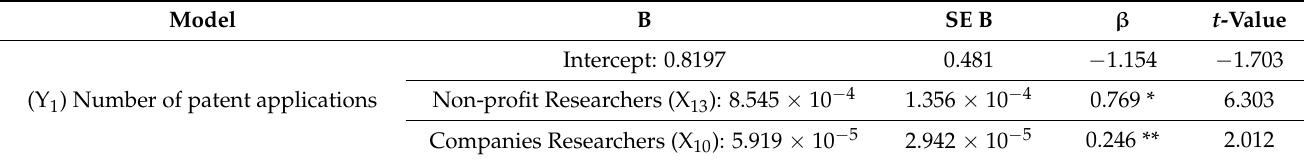
Table 2. Multiple Regression Model for the Number of Patent